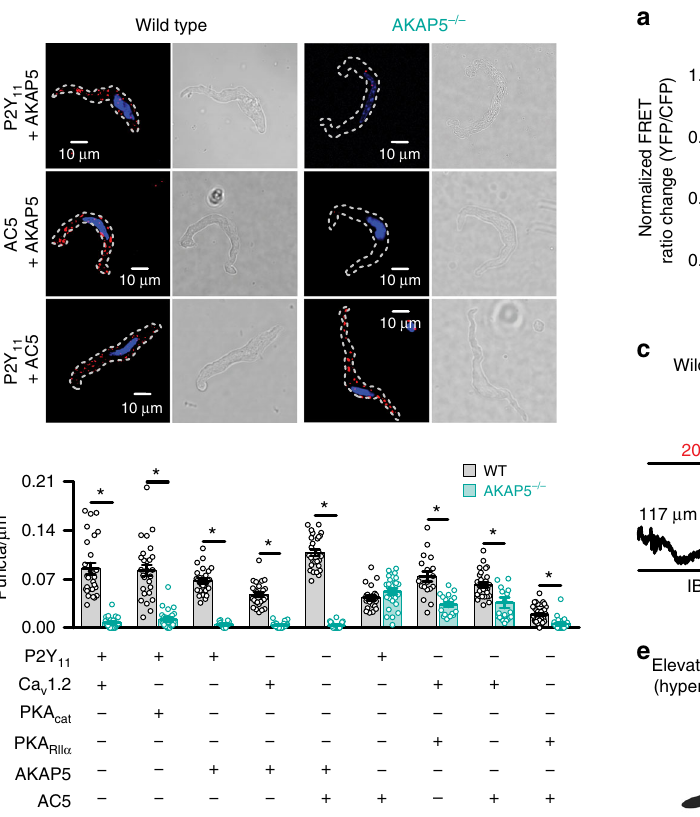
Fig. 6 AKAP5 fosters the P2Y 11 , AC5, PKA, and Ca V 1.2 nanocomplex. a Exemplary merged fl uorescence proximity ligation assay (PLA; red)/nucleus (blue; left panels) and differential interference contrast (right panels) images of wild-type (WT) and AKAP5 − / − cerebral arterial myocytes co-labeled for P2Y 11 + AKAP5, AC5 + AKAP5, and P2Y 11 + AC5. b Quanti fi cation of proximity ligation assay (PLA) fl uorescent puncta per cell area (puncta/ µ m 2 ) for WT and AKAP5 − / − cerebral arterial myocytes labeled for P2Y 11 + Ca V 1.2 ( n = 27 cells/3 WT mice; n = 26 cells/3 AKAP5 − / − mice), P2Y 11 + PKA cat ( n = 27 cells/3 WT mice; n = 26 cells/3 AKAP5 − / − mice), P2Y 11 + prominent associations between P2Y 11 -Ca V 1.2, P2Y 11 -PKA cat , AC5-PKA